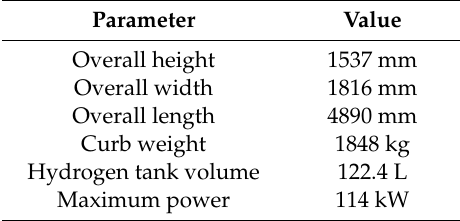
Table 1. Basic parameters of fuel-cell hybrid electric vehicle (FCHEV).